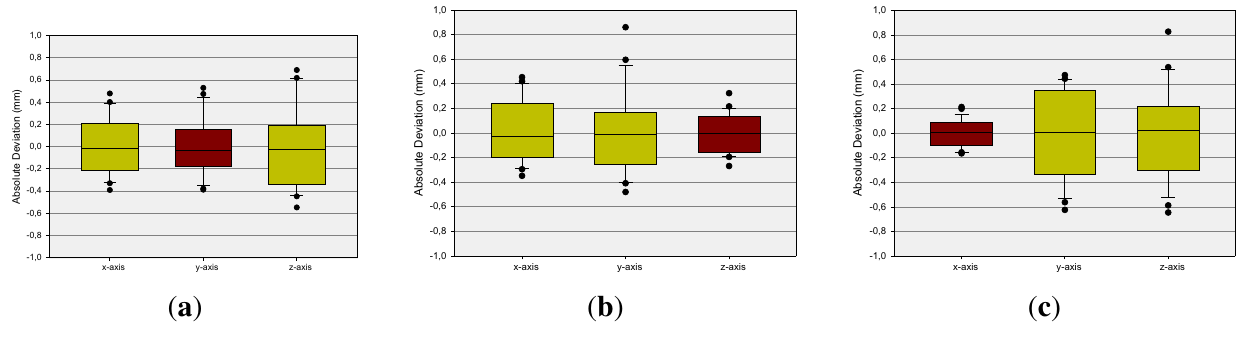
Figure 9. Analysis of Accuracy as Bland–Altman Plots for the three axis-aligned movements of the Test Bar of the Robot for a measuring range from − 100 mm to 100 mm . ( a ) x-axis; ( b ) y-axis; ( c )